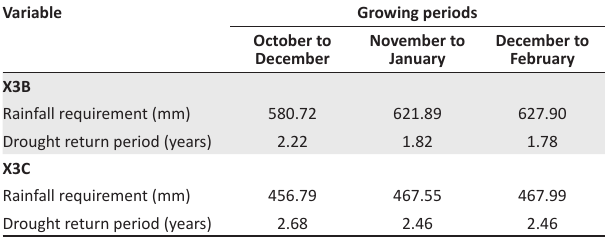
TABLE 5: Rainfall requirements and agricultural return periods.